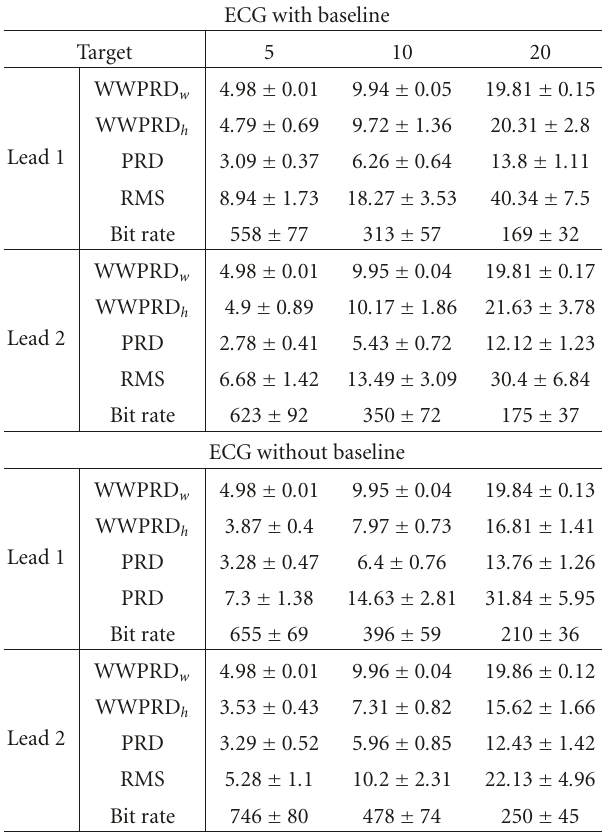
Table 4: Results when guaranteeing WWPRD w in MIT-BIH com- pression. WWPRD w , WWPRD h , and PRD expressed in %, RMS ex- pressed in μV and bit rate in bps).